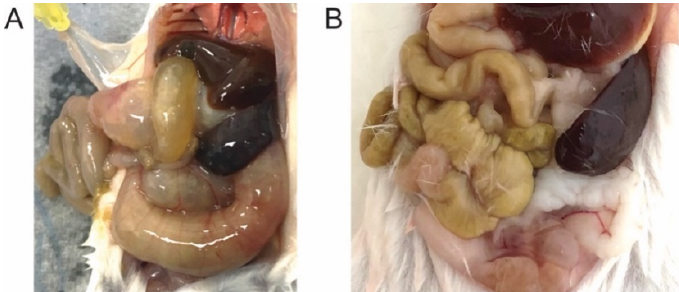
Figure 1. Representative photograph of mice treated with CPX ( A ) and CPX pom ( B ). Macroscopic inflammation can be observed for the CPX treatment, evidencing GI